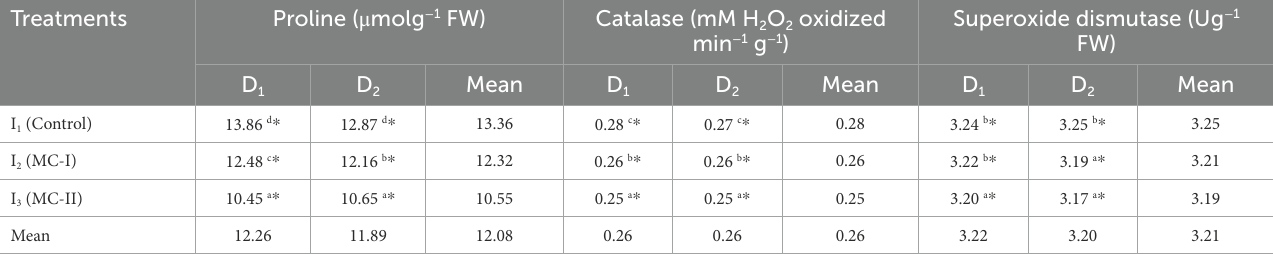
TABLE 5 Effect of halotolerant microbial consortia dosage on stress alleviation in Vigna mungo L. under salinity.